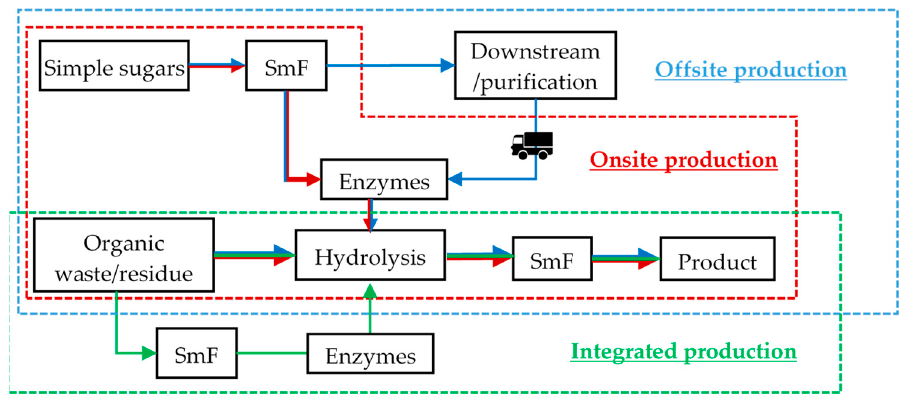
Figure 1. Diagram showing the common offsite production of enzymes (blue box and lines), onsite production of enzymes (red box and lines) and the integrated production of enzymes (green box and lines) as described by Johnson [57].